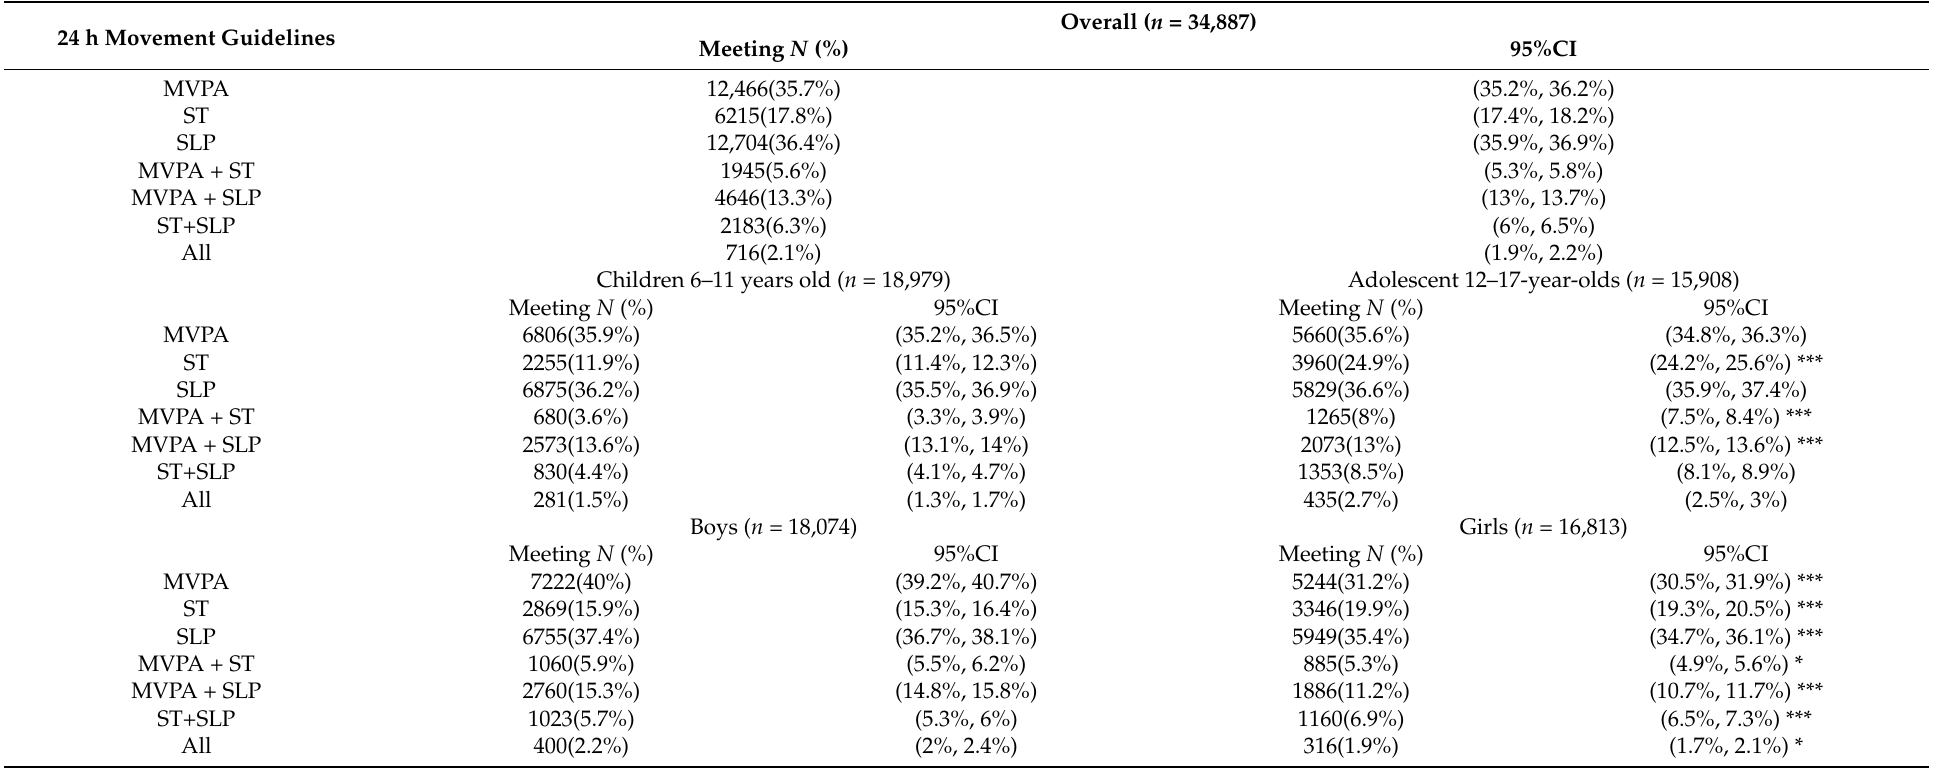
Table 2. Prevalence of meeting the 24-hour movement